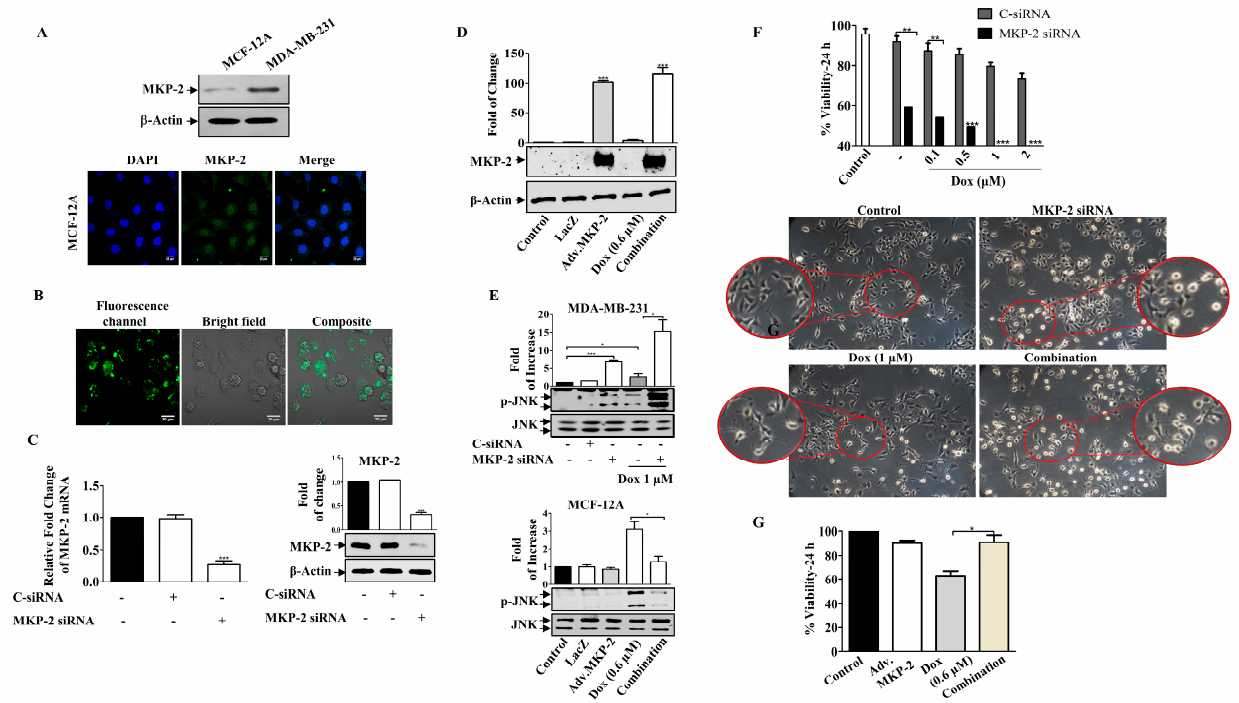
Figure 3. MKP-2 Silencing Induced Breast Cancer Cell Sensitivity to Dox . ( A ) MCF-12A and MDA-MB-231 cell lysates were prepared, separated by SDS-PAGE, and then assessed for MKP-2. In addition, a confocal image of immunofluorescence staining for MKP-2 in MCF-12A cells was taken. MDA-MB-231 cells were transfected with MKP-2 siRNA (10 nm) for 72 h then ( B ) the efficiency was assessed by measuring fluorescence using an MKP-2 siRNA fluorescent negative control and ( C ) by detecting MKP-2 mRNA and protein levels using qRT-PCR and Western blot. ( D ) MCF-12A cells were infected with Adv. MKP-2 (500 pfu/cell) for 24 h, then cell lysates were prepared and assessed for MKP-2 and β -Actin. After transfection or infection with MKP-2, MDA-MB-231, and MCF-12A, cells were treated with Dox (0.6 or 1 µM) for 24 h, and then cell lysates were prepared and assessed for ( E ) p -JNK and JNK, and ( F , G ) cell viability. ( F ) morphological changes were detected using phase contrast microscopy (×20). Each value represents the mean ± S.E.M of three independent experiments. * p ≤ 0.05, ** p ≤ 0.01, *** p ≤ 0.001 compared with the correspondent control.